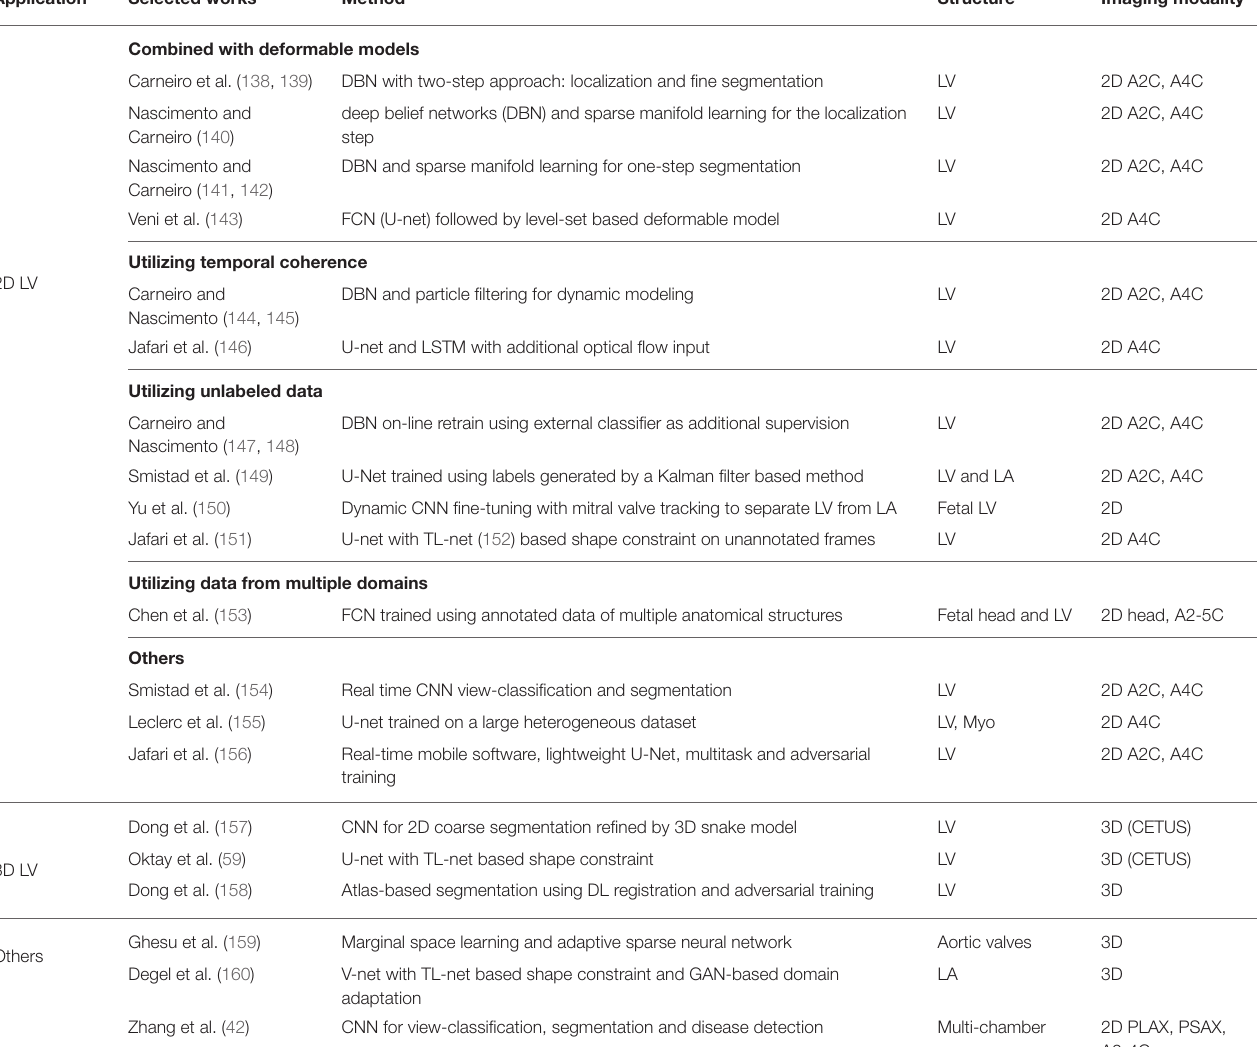
TABLE 5 | A summary of reviewed deep learning methods for ultrasound image segmentation.